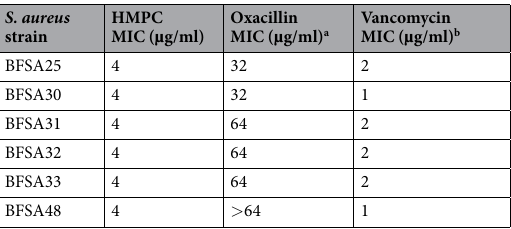
Table 1. Activity of HMPC against methicillin-resistant S. aureus (MRSA) clinical isolates. a,b MIC values for oxacillin and vancomycin are shown for comparison.